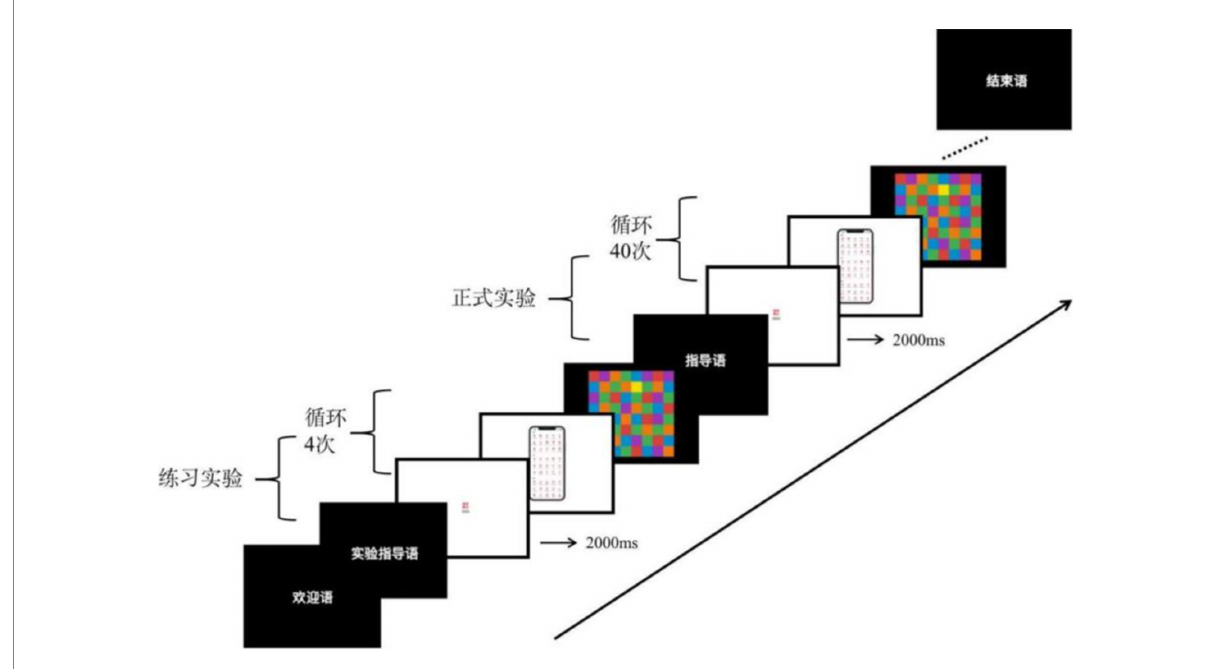
FIGURE 4 Experimental procedure